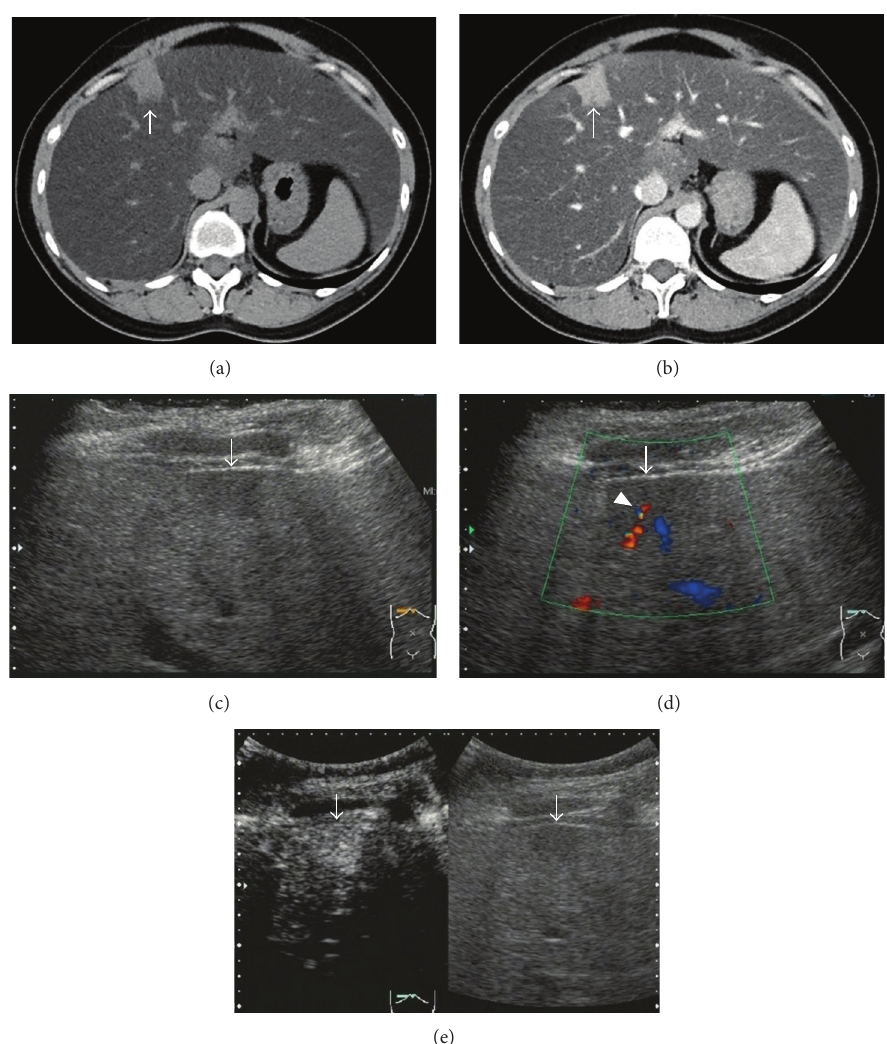
Figure 2: A 35-year-old female (case No. 5) with focal spared lesion in the S4 (near the falciform ligament of liver so called Sappey’s vein area). (a) Unenhanced computed tomography (CT) scan shows a hyperattenuating lesion (arrow) in the S4. (b) Enhanced CT scan shows the lesion (arrow) of hyperattenuation in the portal phase. (c) Gray-scale US (right intercostal axis) shows a hypoechoic lesion (arrow). (d) Color Doppler ultrasonography (CDUS) (right intercostal axis) shows hepato petal flow (arrow head) toward the lesion (arrow). (e) Left: In the vascular phase (13 seconds) of CEUS (right intercostal axis), the lesion (arrow) is hyperenhancement compared with the surrounding liver. Right: Gray-scale US (monitor mode)